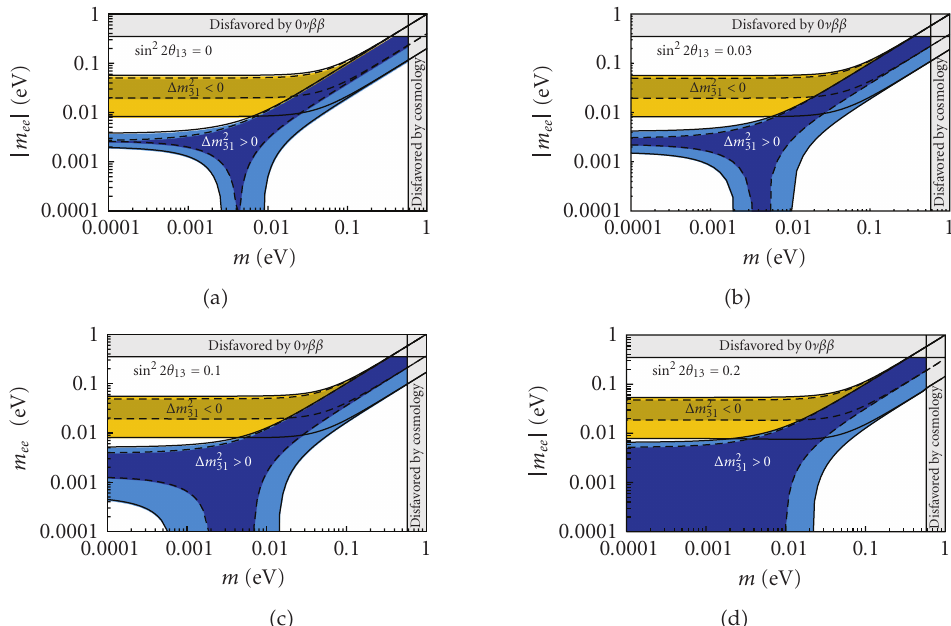
Figure 1: The e ff ective mass as a function of the smallest neutrino mass for the normal and inverted or- dering and for di ff erent values of | U e 3 | 2 . The dark regions are for the best-fit values of the other oscillation parameters, the light regions for their 3 σ